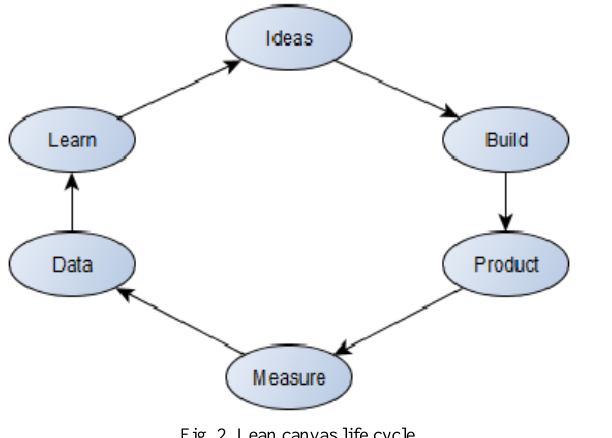
Fig. 2. Lean canvas life cycle.